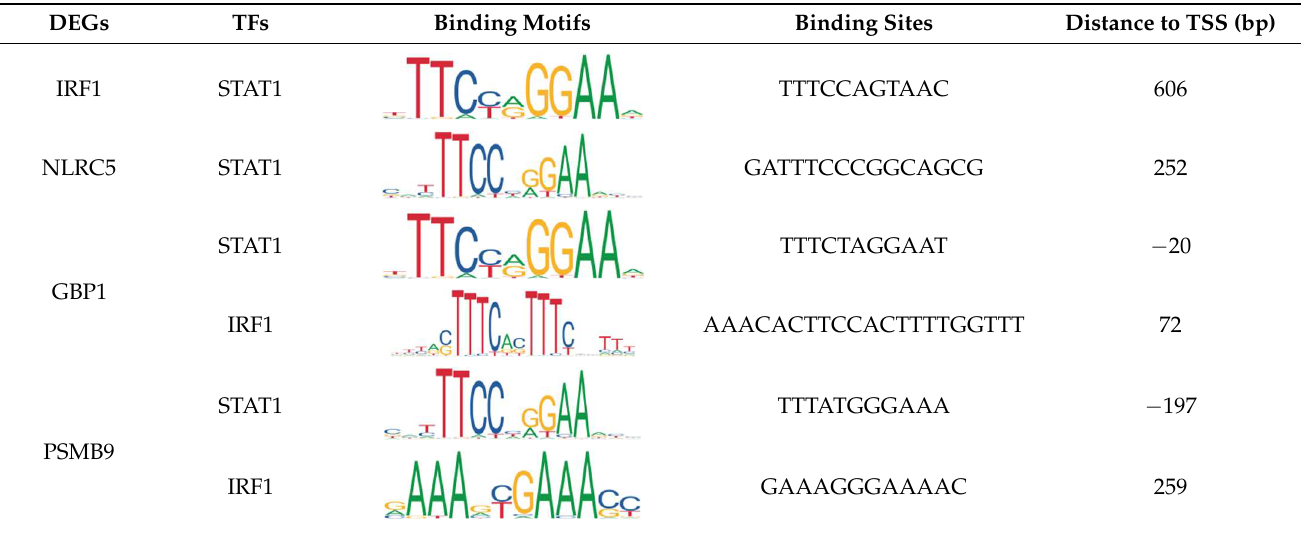
Figure 7. Validation of the promoter activity of immune response processes-related genes by dual- luciferase reporter assays. Data are represented as mean ± SEM, and * p < 0.05, ** p < 0.01, *** p < 0.001. Table 1. Prediction of the binding sites of transcription factors within the TSS ± 1 kb region of immune response processes−related genes in GD15M_CM *.